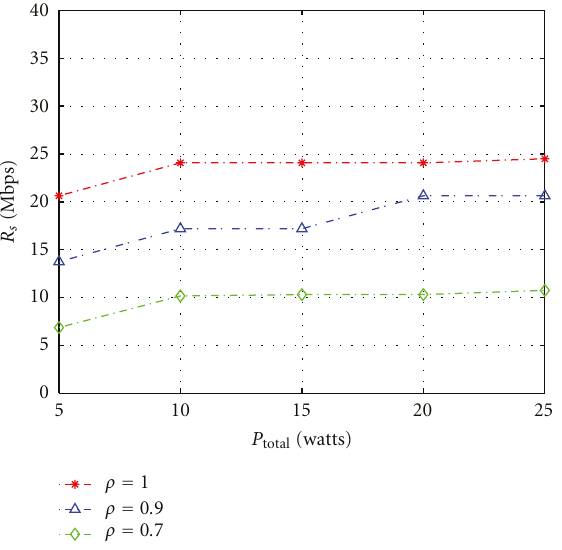
Figure 5: Average total CRU bit rate, R s , versus total CRU transmit power, P total , with I total = 0 . 02W, P m = 5W, and ρ = 0 .